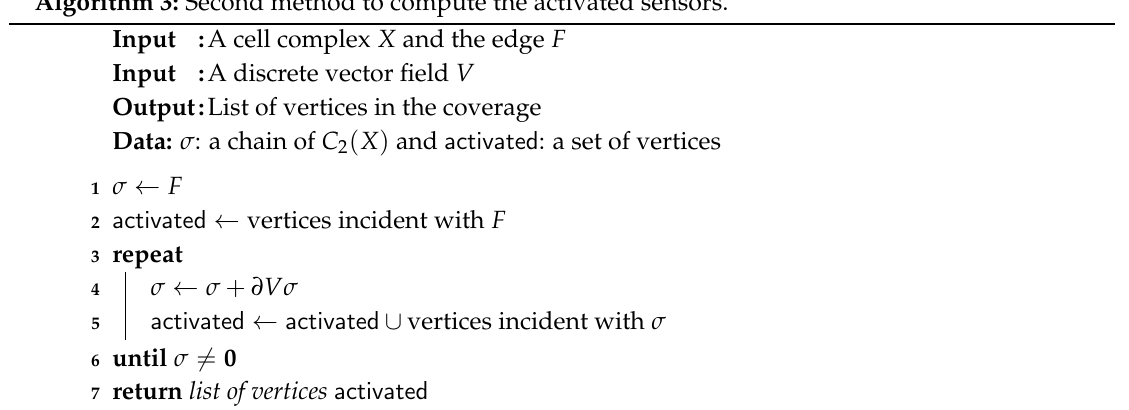
Algorithm 3: Second method to compute the activated sensors.